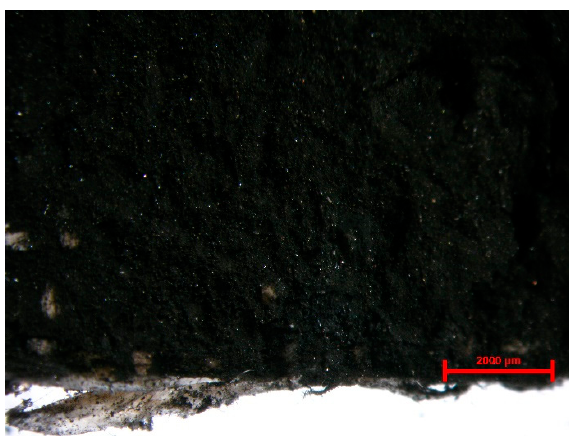
Figure 3. Fragment of sample of SP trapped by the filter.